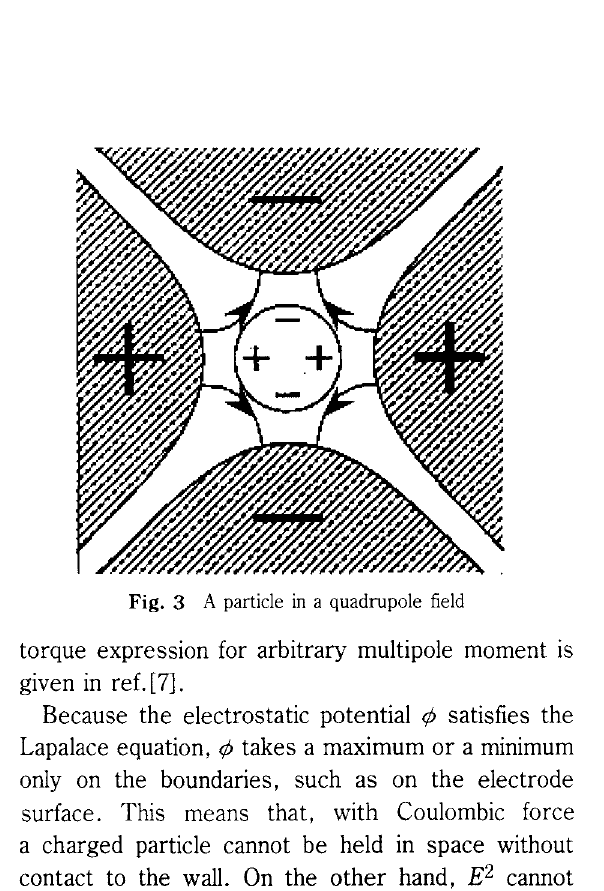
Fig. 3 A particle in a quadrupole